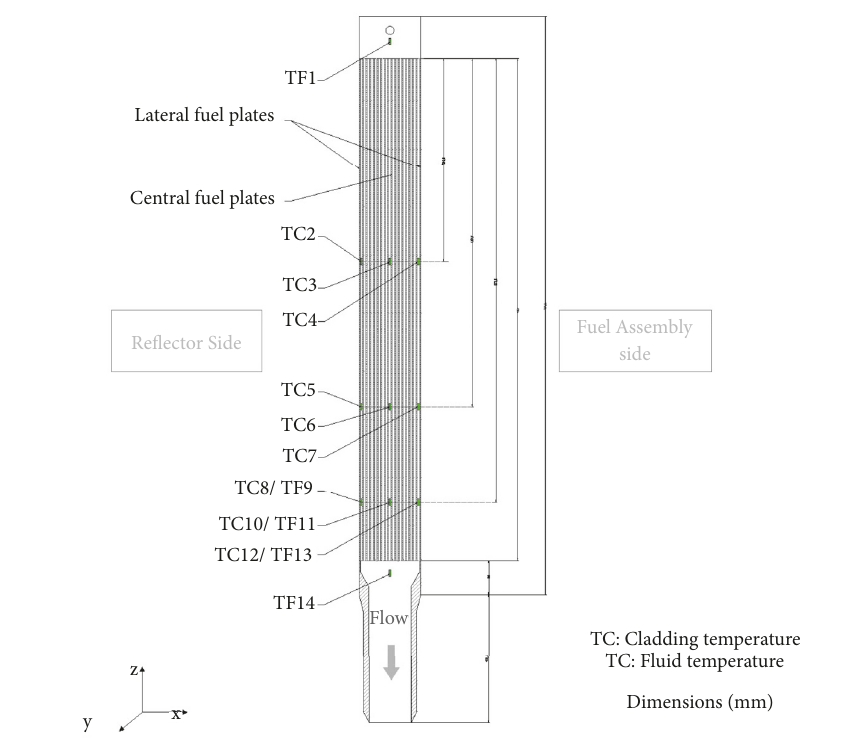
Figure 6: Thermocouples positions in the Instrumental Fuel Assembly (side view). Adapted from [26]. Table 1: Measurement variables from the IEA-R1 reactor utilized in the COTENP code validation. Temperature variables are measured in the IFA and flow rate and pressure drop are measured in the dummy fuel assembly ( Δ P) [22]. Location Measurement